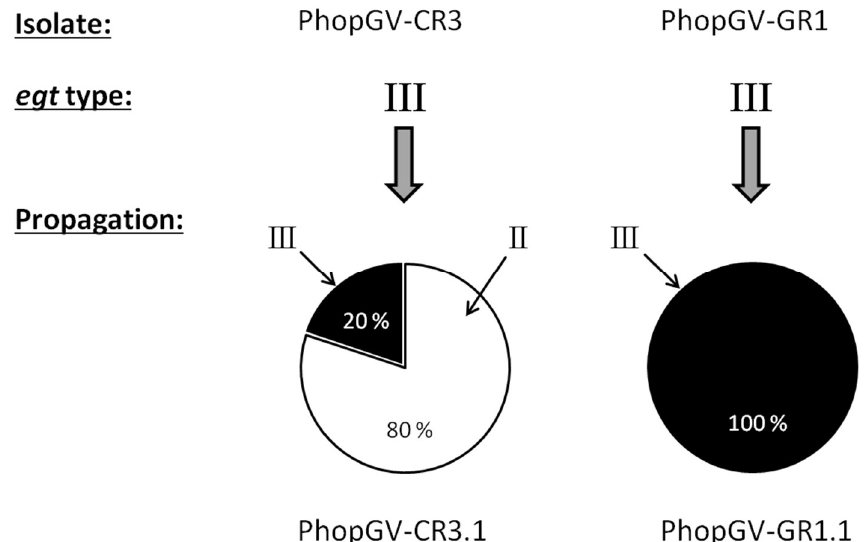
Figure 6. Quantification (%) of the egt types of PhopGV-CR3 and -GR1, based on the de novo assembled reads of the Illumina sequencing data after propagation in P. operculella population Phop-IT. The egt type is indicated with roman numbers.